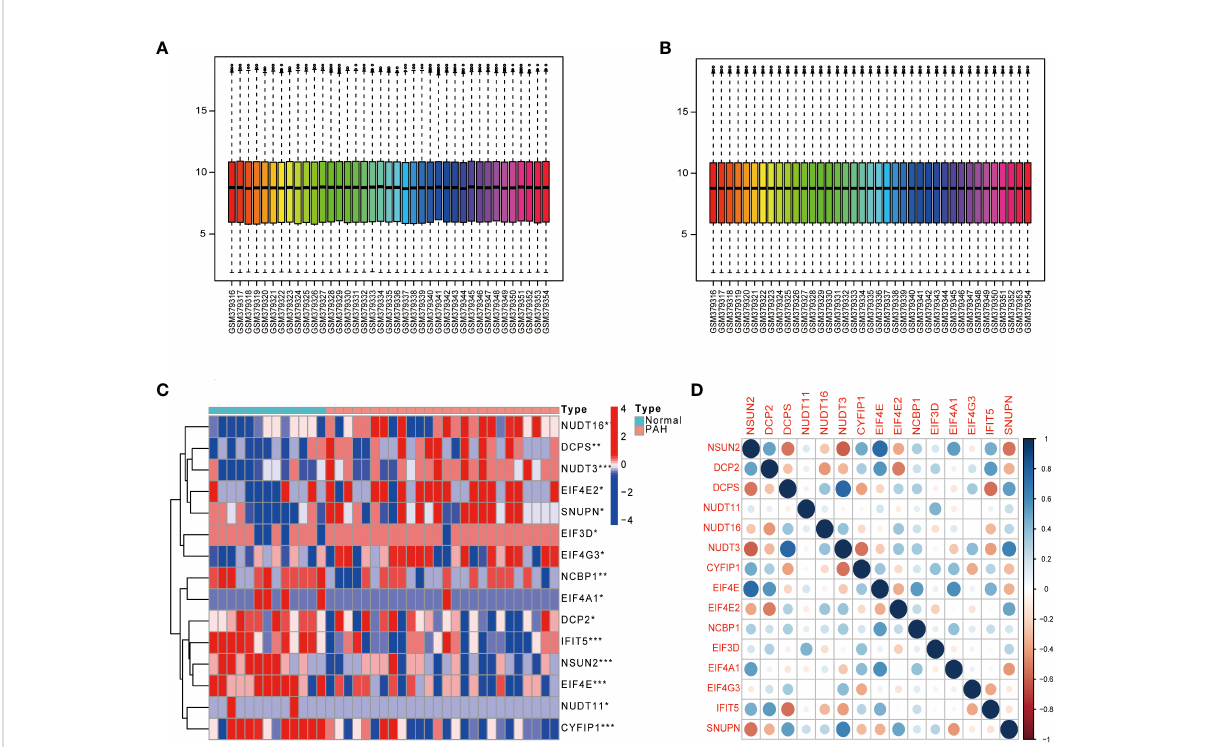
FIGURE 1 Gene differential expression analysis. (A) GSE15197 data before normalization. (B) GSE15197 normalized data. (C) Differential expression of m 7 G- regulated genes in PAH patients and normal controls. (D) Heat map of the correlation of m 7 G genes. Both horizontal and vertical coordinates represent genes, and different colors represent correlation coef fi cients (blue represents positive correlation and red represents negative correlation in the diagram). *P < 0.05, **P < 0.01 and ***P < 0.001. asterisks (*) stand for signi fi cance